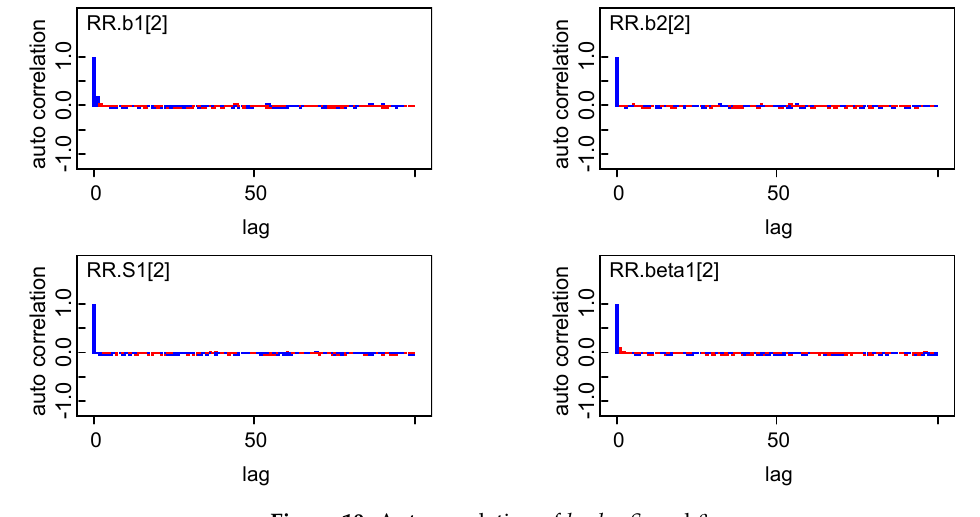
Figure 10. Autocorrelation of b 1 , b 2 , S , and β .